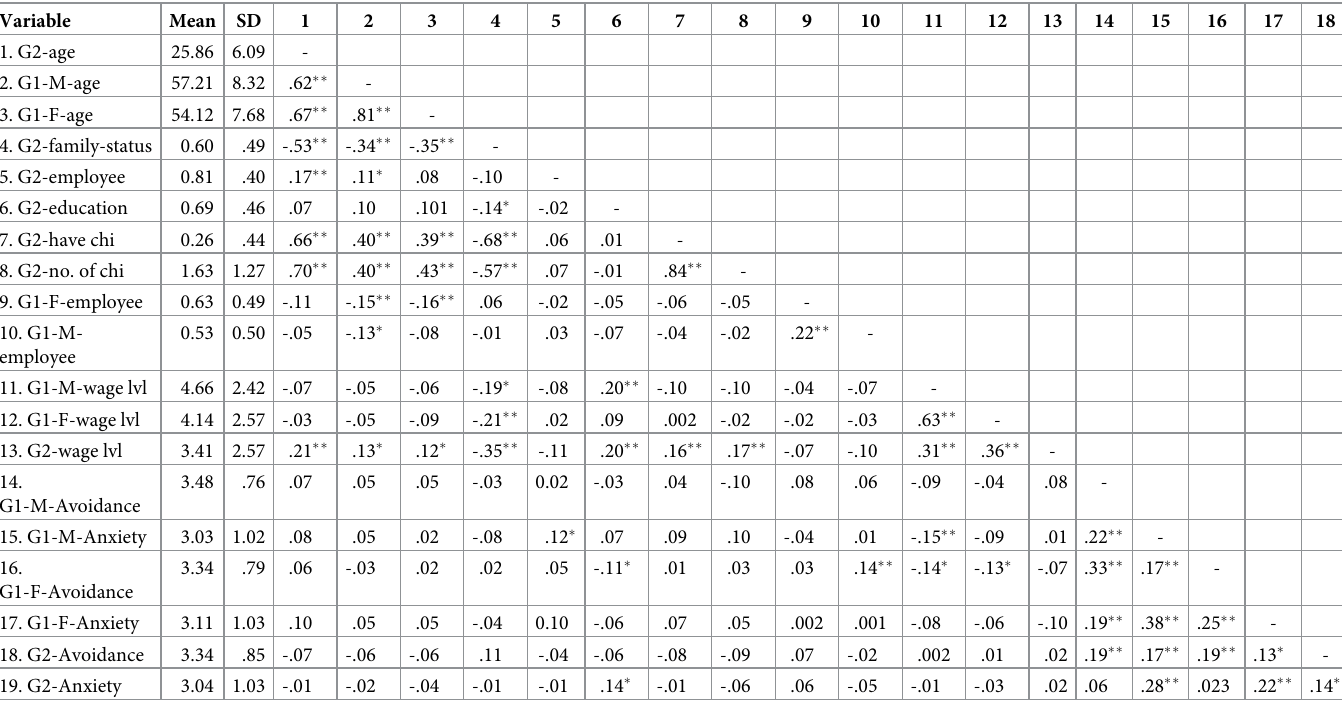
Table 1. Means, standard deviations, and intercorrelations for the variables (general